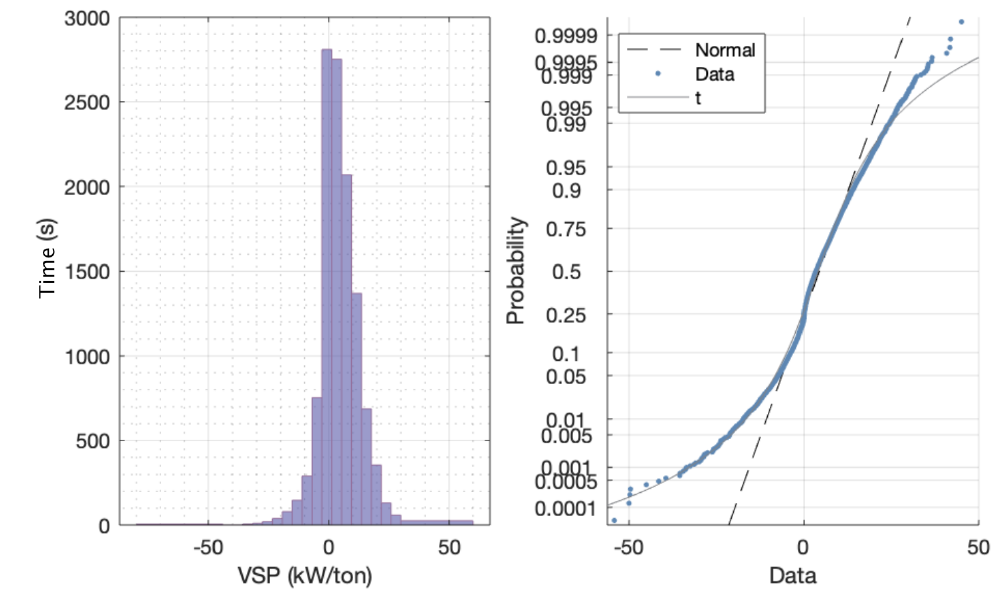
Figure 8. Histogram and probability plot for tests using gasohol